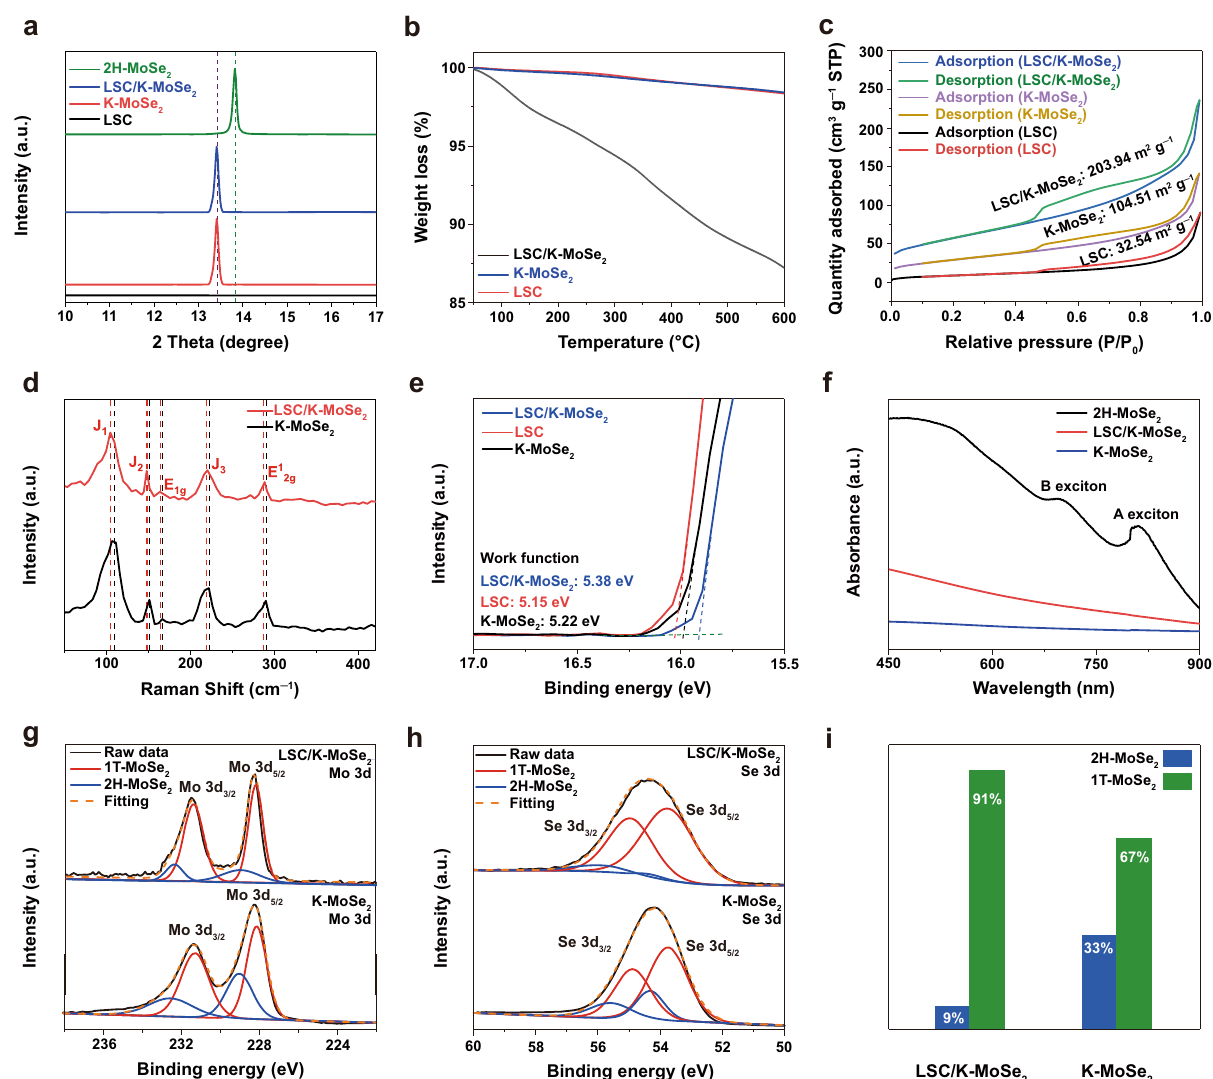
Fig. 3 Characterization of the LSC/K-MoSe 2 heterostructure. a XRD patterns for 2H-MoSe 2 , LSC/K-MoSe 2 , K-MoSe 2 , and LSC, demonstrating that each of the K-MoSe 2 and LSC phases are well preserved in LSC/K-MoSe 2 . b TGA analysis of LSC/K-MoSe 2 , K-MoSe 2 , and LSC, indicating the improved surface adsorption capability of LSC/K-MoSe 2 . c BET surface area of LSC/K-MoSe 2 , K-MoSe 2 , and LSC obtained from N 2 adsorption/desorption isotherms. d Raman spectra of LSC/K-MoSe 2 and K-MoSe 2 , illustrating the electronic interaction between LSC and K-MoSe 2 . e UPS valence band spectra of LSC/K- MoSe 2 , LSC, and K-MoSe 2 . f UV – Vis – NIR spectra of 2H-MoSe 2 , LSC/K-MoSe 2 , and K-MoSe 2 , indicating the metallic features of LSC/K-MoSe 2 and K- MoSe 2 . g , h High-resolution XPS spectra of Mo 3d and Se 3d peaks for LSC/K-MoSe 2 and K-MoSe 2 . i Relative fraction of 2H- and 1T-MoSe 2 in LSC/K- MoSe 2 and K-MoSe 2 , indicating the substantial increase of the 1T-phase ratio in MoSe 2 through complementary charge